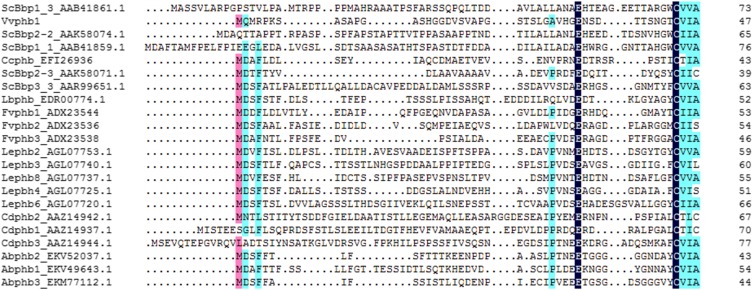
Alignments of pheromone precursor protein sequences of mushroom forming fungi V. volvacea (Vv), S. commune (Sc), C. cinerea (Cc), L. bicolor (Lb), and F. velutipes (Fv), showing typical conservation of the CAAX motifs, and a Glu (E) at a position ∼10 AA upstream from the CAAX motif, which are both needed for proper maturation. Conservation of AAs is indicated by shading with black (complete), purple (high), and light blue (medium).